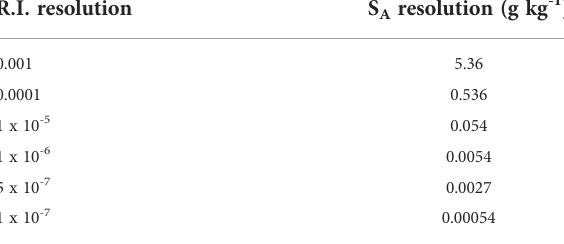
TABLE 1 Equivalences between R.I. and Absolute Salinity